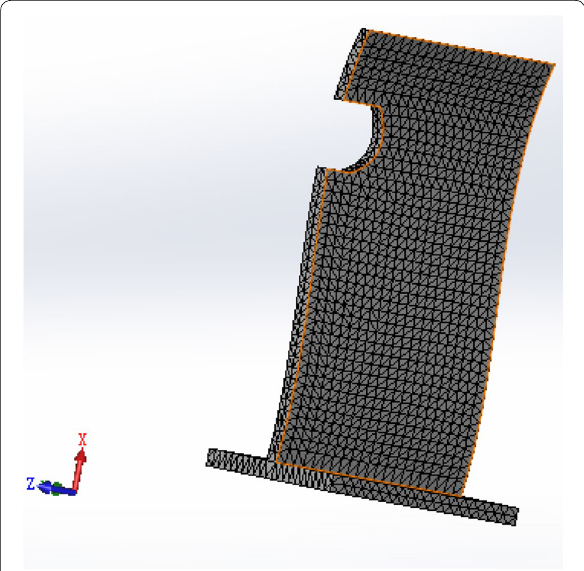
Figure 18 Turbine blade damage model Table 1 Turbine blade original model node coordinate set Node